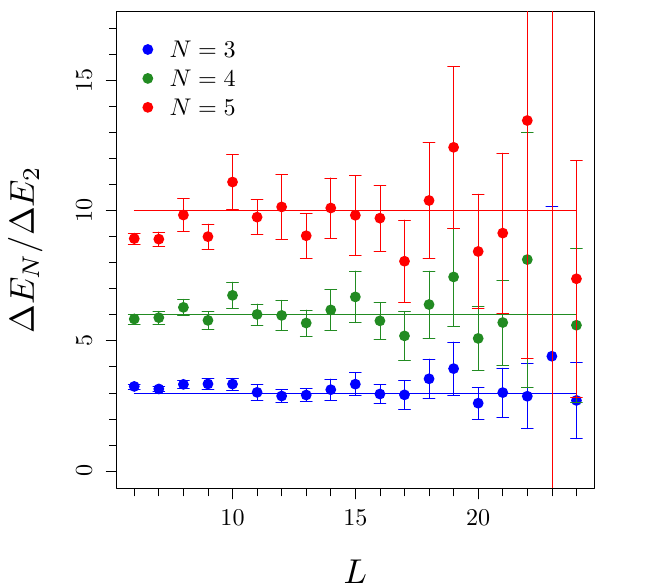
Figure 7. Energy shift ratios in dependency of the lattice parameter L . For orientation the colored straight lines mark the ratio values 3 , 6 , 10